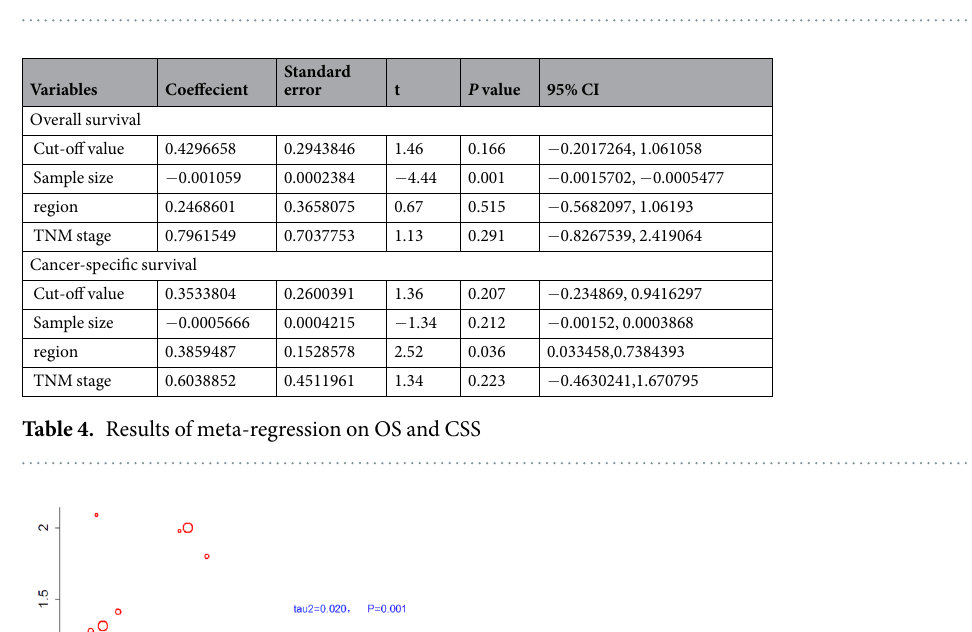
Table 3. Relationship between pretreatment GPS and lymphatic invasion and venous invasion.